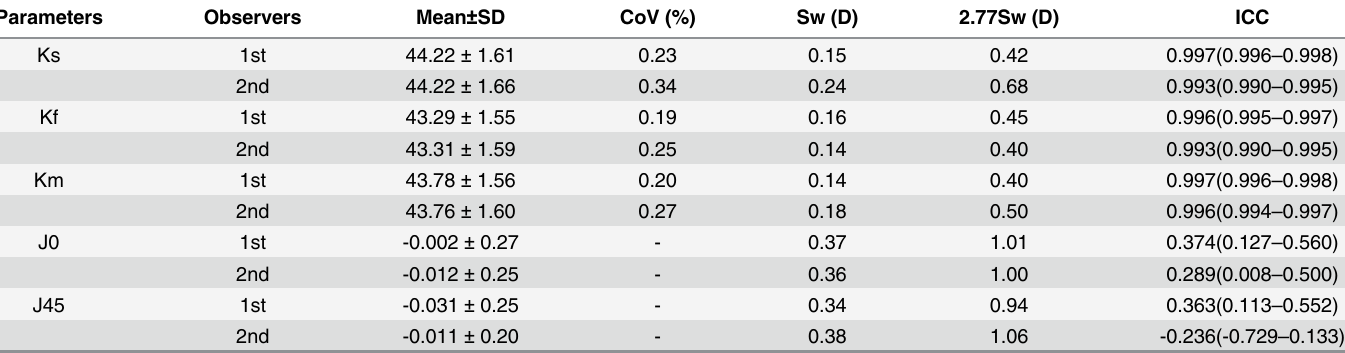
Table 1. The intraobserver repeatability of Ks, Kf, Km, J0 and J45 obtained by Topcon KR-1W. (Note: D: diopter, SD: standard deviation, Sw: within- subject standard deviation, CoV: within-subject coefficient of variation, ICC: intraclass correlation coefficient.) Parameters